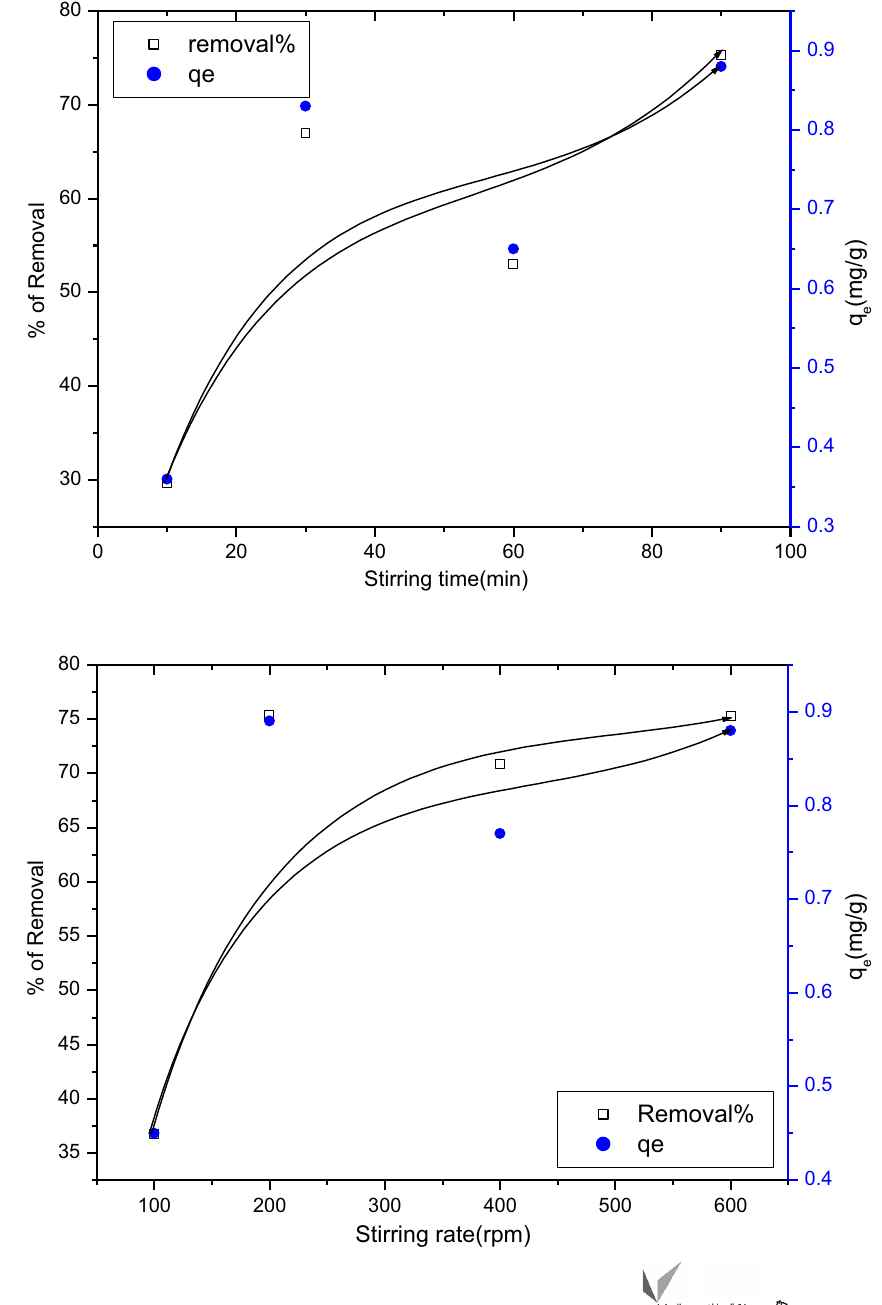
Fig. 7 Effect of stirring time on the adsorption of CR dye by banana peel